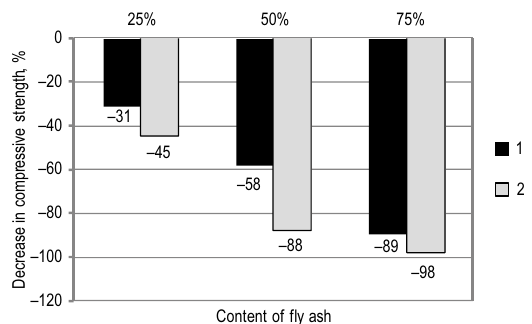
Content of fly Fig. 6. Decrease in compressive strength depending on the content of flying ash and the type of soil: 1 – sand soil, 2 – clay soil